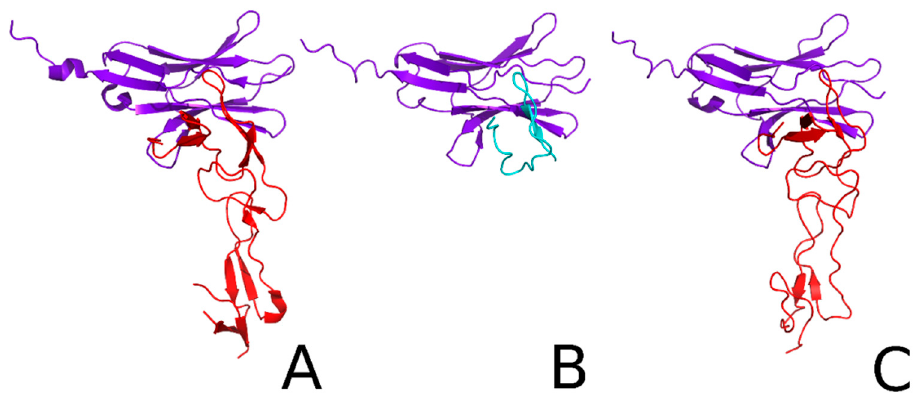
Figure 2. ( A ) Crystal structure of the B-and T-lymphocyte attenuator / herpes virus entry mediator complex (PDB code: 2AW2), in which the purple color indicates BTLA and red indicates HVEM. ( B ) ThedominantclusteroftheHVEM(14–39)peptide–BTLAcomplexobtainedfromUNRESsimulation, in which the purple color indicates BTLA and cyan blue indicates the peptide. ( C ) The fourth cluster of the BTLA / HVEM complex obtained from UNRES simulation, in which HVEM and BTLA are highlighted as red and purple,